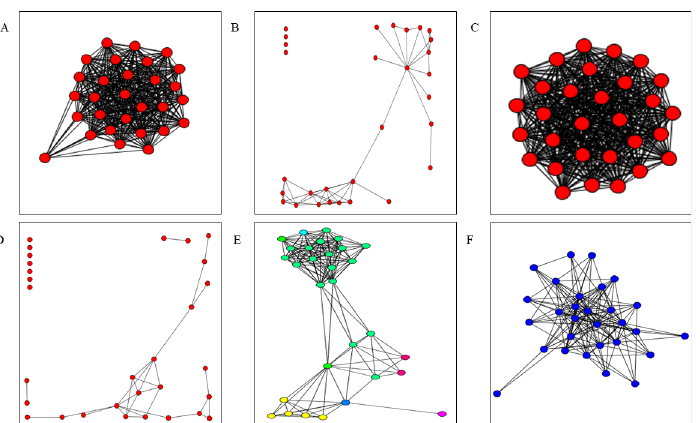
Fig 2. Examples of social networks from our study with representative measures. Unconnected red circles indicate isolated alters. A) Network with a low mean betweenness of 1.00. B) Network with a high mean betweenness of 23.27. C) Network with a low mean distance of 1.005. D) Network with a high mean distance of 3.214. E) Network with a low percentage of family members (shown in blue), 6.0%. F) Network with a high percentage of family members (shown in blue), 100%.